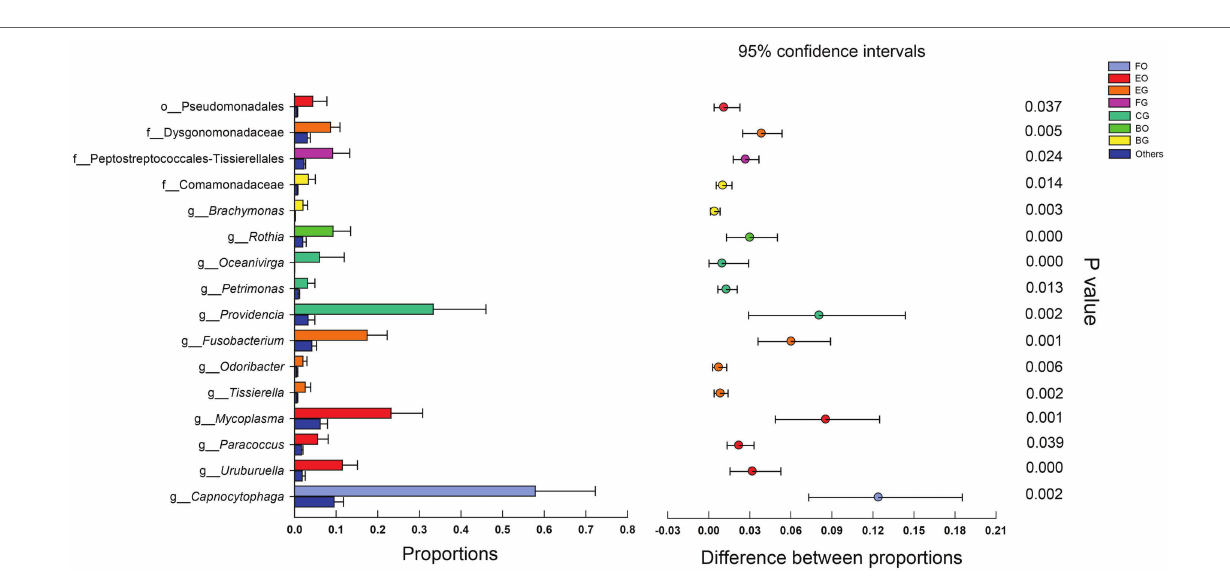
FIGURE 5 | Microbial relative abundance differences in different groups. The error bars are standard deviations error. The star indicates ( p < 0.05) using Mann- Whitney U test. See Figure 1 for the definition of every group. The letters “o,” “f,” and “g” indicate order, family, and genus,